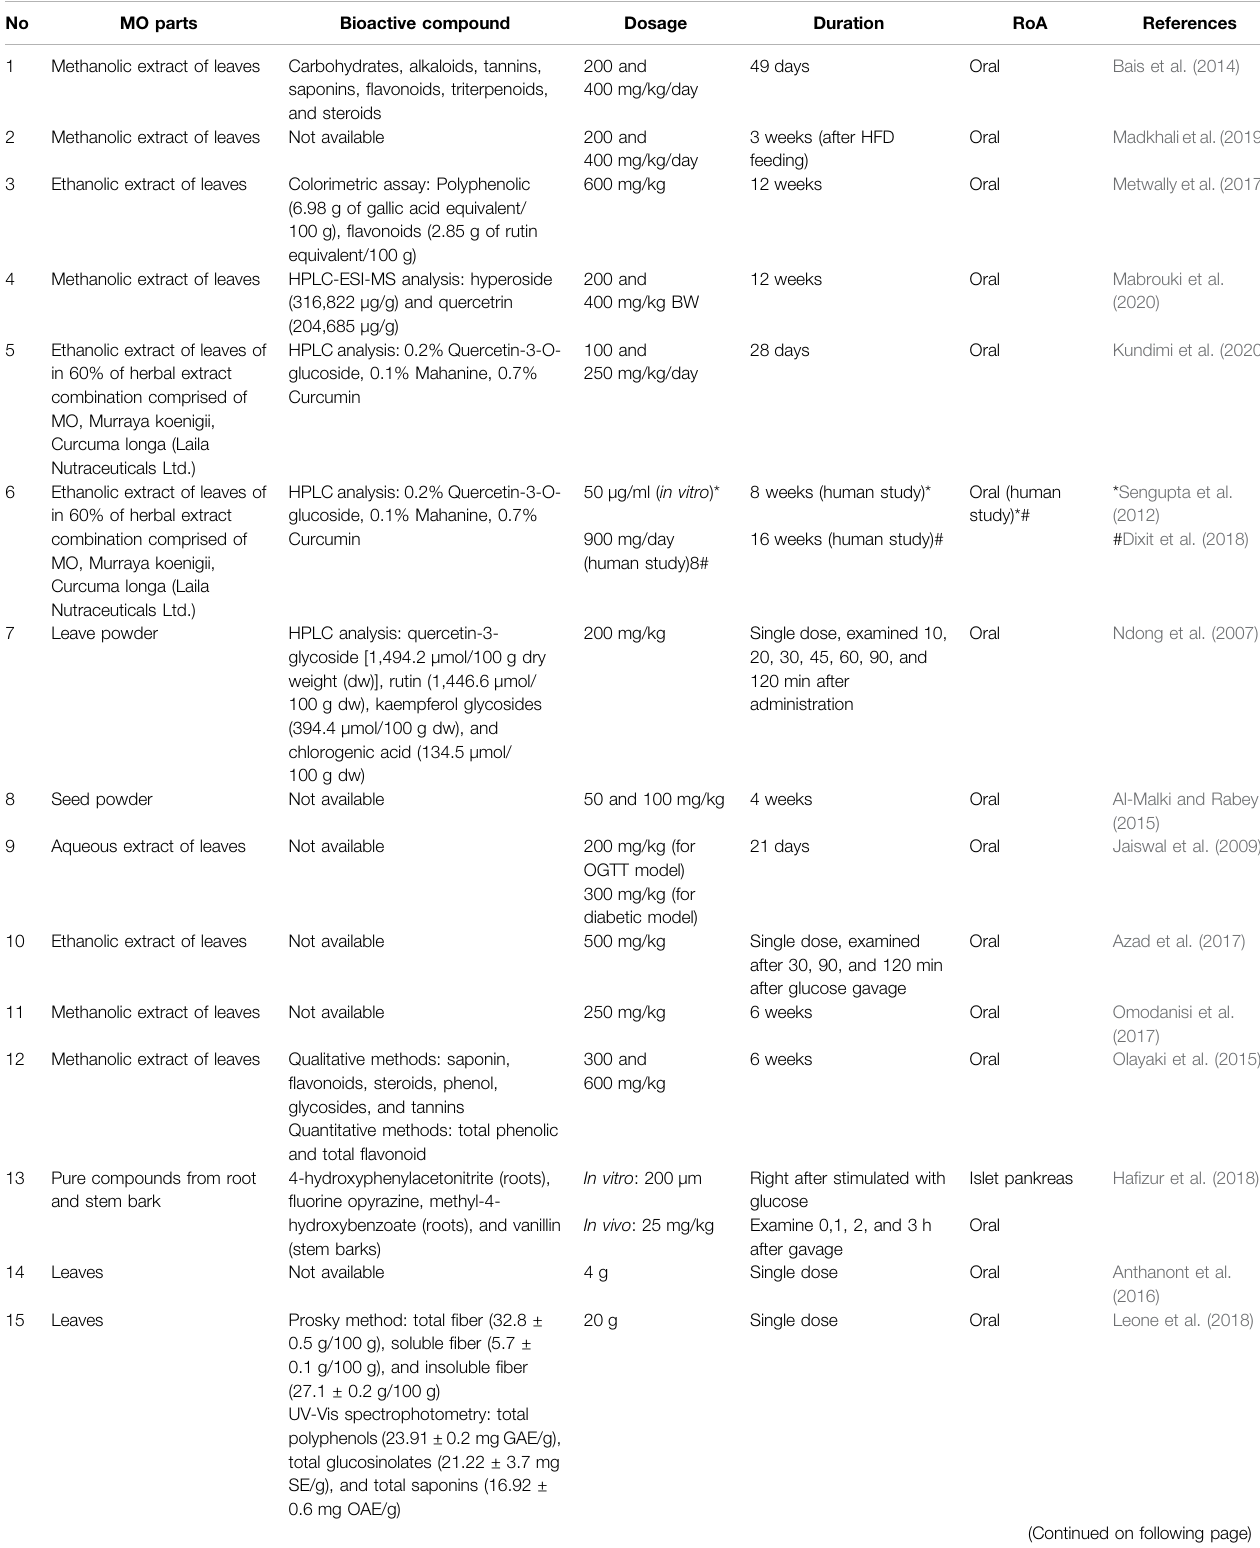
TABLE 3 | Experimental approach of Moringa oleifera in CVD fi